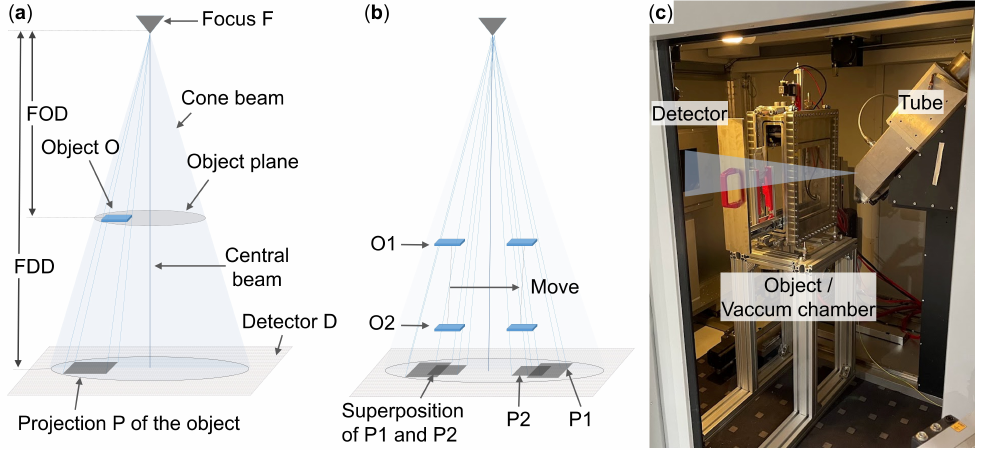
Figure 1. ( a ): Definition of basic terms of an X-ray inspection with cone beam. ( b ): Illustration of superposition and the effects of the central beam projection in a radiography. ( c ): Convetionional X-ray inspection machine and experimental setup for visualization of the electrolyte filling machine (cf. Section